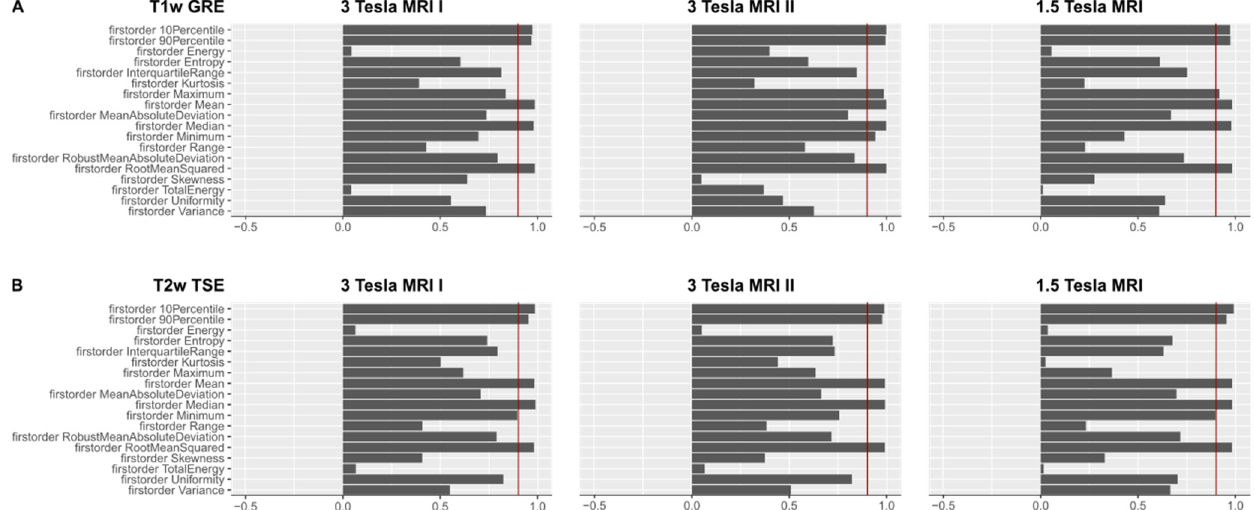
Figure 3. ( A ). OCCCs 20,30 of the first-order features derived from T1w images are shown for the three different MR scanners. The red benchmark at 0.9 indicates excellent agreement in the OCCCs. Mean, median, RMS, 90th, and 10th percentile showed excellent agreement on all three MR scanners. On the 3 Tesla MR scanner II, also maximum and minimum achieved excellent agreement in the OCCCs. Mean, median, and RMS also showed excellent agreement in the OCCCs 10–30 (not shown), whereas excellent agreement of the 90th and 10th percentile was inconsistent. A summary of the numerical results of the OCCCs on different scanners and pulse sequences is listed in Supplementary Material 5 (see Table SF5). Complete figures of OCCCs of all features, scanners, and sequences are shown in the Supplementary Files 6–8 (see Figures SF6–SF8). ( B ). OCCCs 20,30 of the first-order features derived from T2w images are shown for the three different MR scanners. The red benchmark at 0.9 indicates excellent agreement in the OCCCs. Mean, median, RMS, 90th, and 10th percentile showed excellent agreement on all three MR scanners. On the 3 Tesla MRI I and the 1.5 Tesla scanner, also minimum achieved excellent agreement in the OCCCs 20,30 . Mean, median, and RMS also showed excellent agreement in the OCCCs 10–30 (not shown), whereas excellent agreement of minimum, 90th and 10th percentile was inconsistent. A summary of the numerical results of the OCCCs on different scanners and pulse sequences is listed in Supplementary Material 5 (see Table SF5). Complete figures of OCCCs of all features, scanners, and sequences are shown in the Supplementary Files 6–8 (see Figures SF6–SF8).